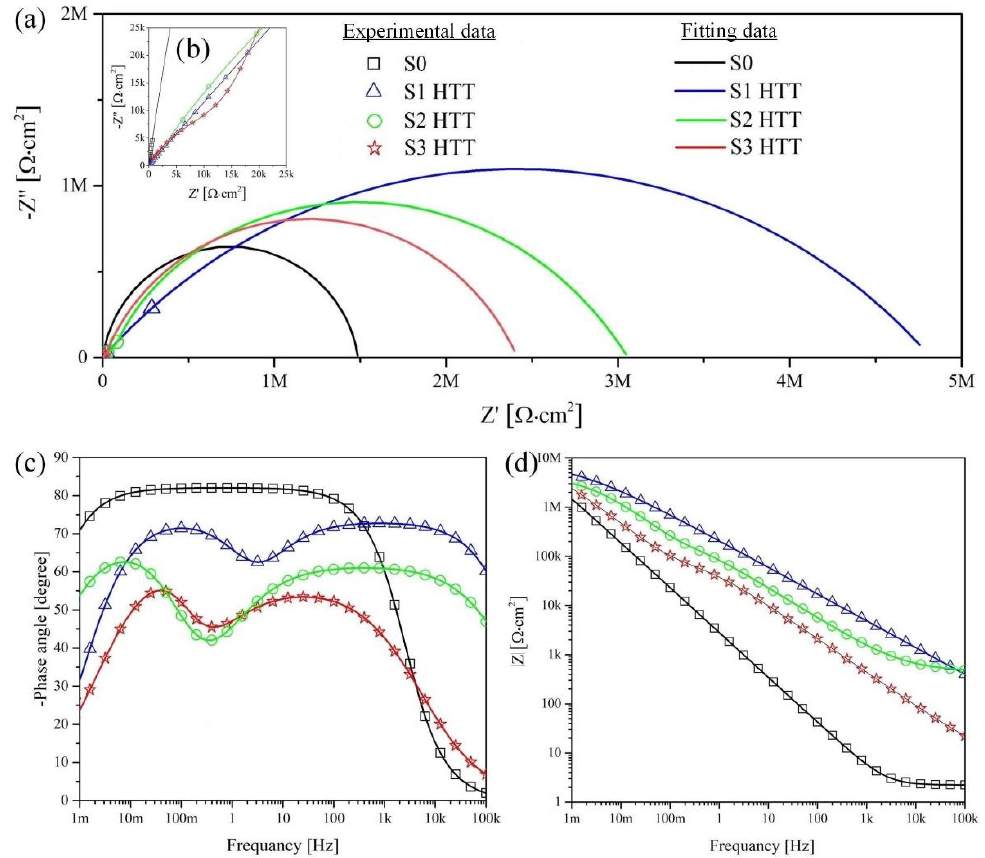
Figure 11. The Nyquist and Bode plots for the S0 and S1 HTT–S3 HTT samples obtained in Hanks’ solution: ( a ) Curves for the full frequency range of the impedance; ( b ) low-frequency impedance curves; ( c ) Bode-phase plots; ( d ) Bode impedance plots. Symbols refer to experimental values, and solid lines refer to fitted data.